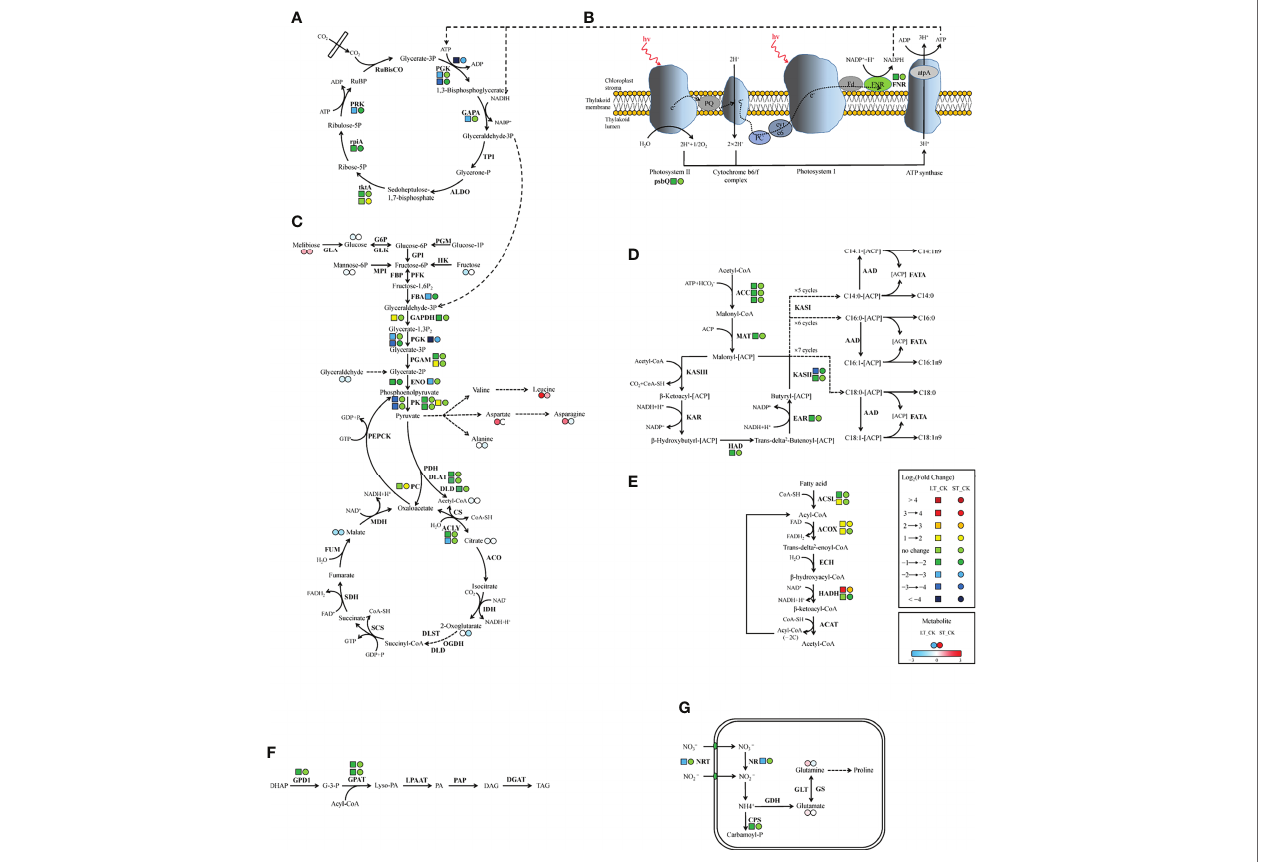
FIGURE 9 | Schematic representation of genes and metabolites changes in C and N metabolic pathways in N. oceanica under ocean acidification. (A) Calvin cycle. (B) Photosynthesis. (C) Glycolysis/gluconeogenesis and TCA cycle. (D) Fatty acid biosynthesis. (E) β -oxidation. (F) Triacylglycerol biosynthesis. (G) Nitrogen metabolism. Key enzymes and metabolites were included in the map. Next to the enzyme, left tetragon represents LT vs. CK; right circle represents ST vs. CK. Two adjacent circles next to the metabolite, left circle representsLT vs. CK and right circle represents ST vs. CK (red in upregulated, blue in downregulated). CK, control; ST, short-term acidification; LT, long-term acidification. RuBisCO, ribulose bisphosphate carboxylase; PGK, phosphoglycerate kinase; GAPA, glyceraldehyde-3- phosphate dehydrogenase; TPI, triosephosphate isomerase; ALDO, fructose-bisphosphate aldolase; tktA, transketolase; rpiA, ribose 5-phosphate isomerase A; PRK, phosphoribulokinase; psbQ, photosystem II oxygen-evolving enhancer protein 3; FNR, ferrdoxin-NADP+ reductase; PGM, phosphoglucomutase; GLA, galactosidase; G6P, glucose-6-phosphatase; GLK, glucokinase; GPI, glucose-6-phosphate isomerase; HK, hexokinase; MPI, mannose-6-phosphate isomerase; FBP, fructose-1,6-bisphosphatase; PFK, phosphofructokinase; FBA, fructose-bisphosphate aldolase; GAPDH, glyceraldehyde-3-phosphate dehydrogenase; PGAM, 2,3-bisphosphoglycerate-dependent phosphoglycerate mutase; ENO, enolase; PK, pyruvate kinase; PDH, pyruvate dehydrogenase; DLAT, dihydrolipoamide acetyltransferase; DLD, dihydrolipoamide dehydrogenase; PC, pyruvate carboxylase; PEPCK, phosphoenolpyruvate carboxykinase; CS, citrate synthase; ACLY, ATP citrate lyase; ACO, aconitate hydratase; IDH, isocitrate dehydrogenase; OGDH, 2-oxoglutarate dehydrogenase; DLST, dihydrolipoamide succinyltransferase; SCS, succinyl-CoA synthetase; SDH, succinate dehydrogenase; FUM, fumarate hydratase; MDH, malate dehydrogenase; ACC, acetyl- CoA carboxylase; MAT, malonyl-CoA-[acyl-carrier-protein] transacylase; KAS, β -ketoacyl-[acyl-carrier-protein] synthase; KAR, β -ketoacyl-[acyl-carrier protein] reductase; HAD, β -hydroxyacyl-[acyl-carrier-protein] dehydratase; EAR, enoyl-[acyl-carrier-protein] reductase; AAD, acyl-[acyl-carrier-protein] desaturase; FATA, fatty acyl-[acyl-carrier-protein] thioesterase A; ACSL, long-chain acyl-CoA synthetase; ACOX, acyl-CoA oxidase; ECH, enoyl-CoA hydratase; HADH, β -hydroxyacyl- CoA dehydrogenase; ACAT, acetyl-CoA C-acetyltransferase; DHAP, dihydroxyacetone phosphate; GPD1, glycerol-3-phosphate dehydrogenase (NAD+); G-3-P, glycerol-3-phosphate; GPAT, glycerol-3-phosphate acyltransferase; PA, phosphatidic acid; Lyso-PA, lysophosphatidic acid; LPAAT, Lyso-PA acyltransferase;